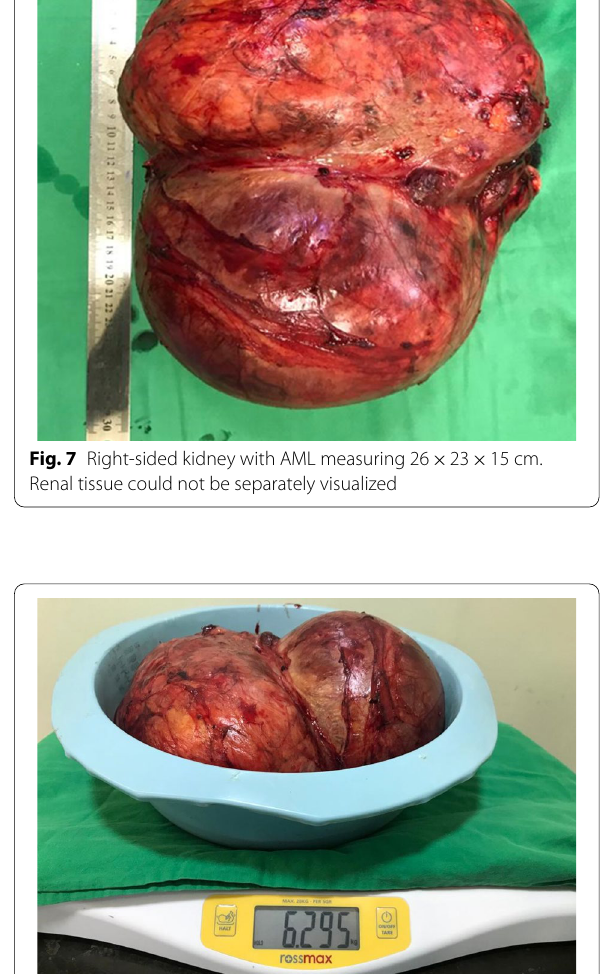
Fig. 8 Right-sided kidney with AML measuring 26 Renal tissue could not be separately